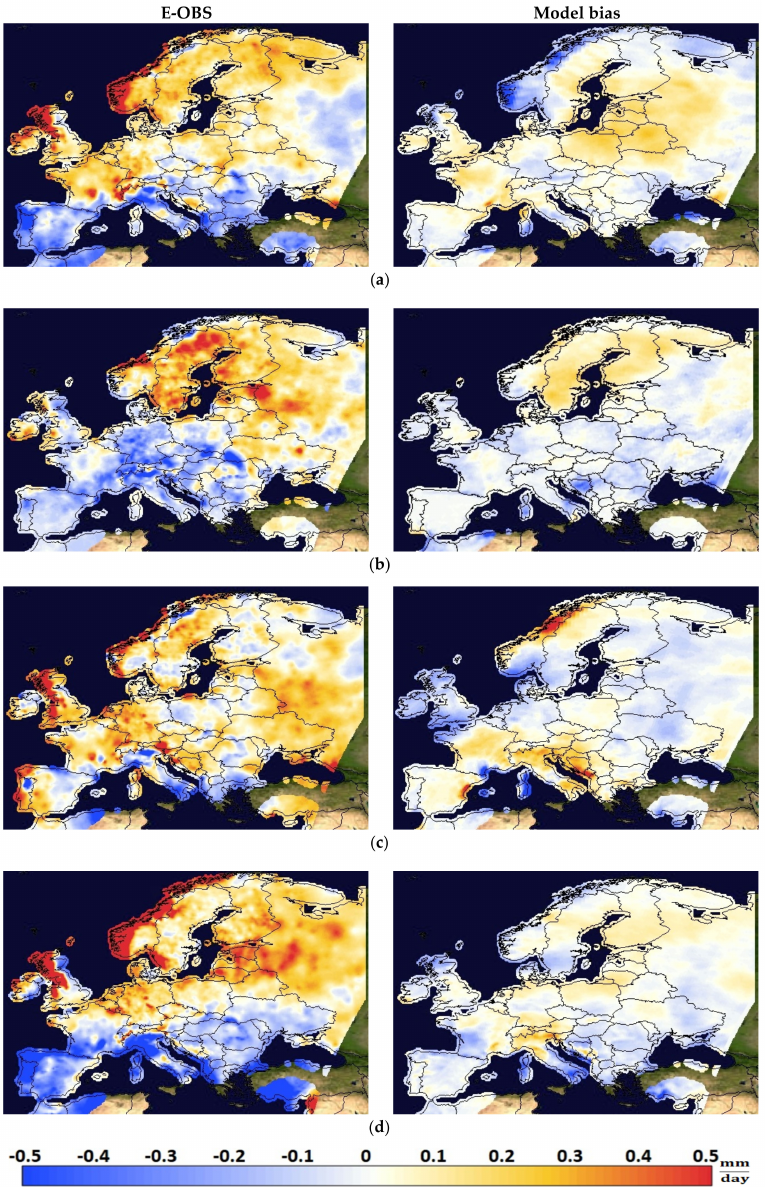
Figure 6. Seasonal mean precipitation changes observed (E-OBS, left panels) and the related model biases (E-OBS-model, right panels) between current and historic periods for ( a ) spring